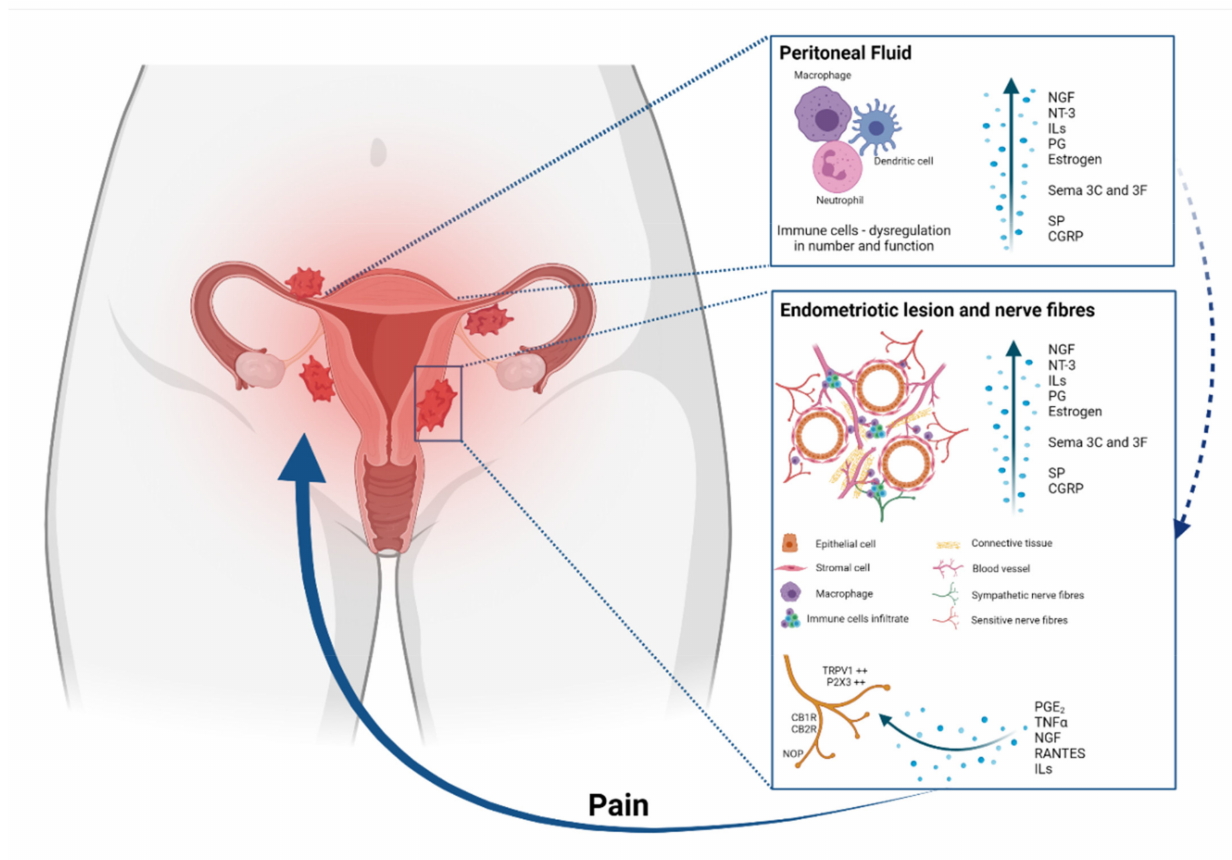
Figure 1. Main pathways involved in the pathogenesis of inflammatory pain in endometriosis. Endometrial fragments in the peritoneum lead to peritoneal inflammation. The same immune response is seen at endometriotic lesions, where the increased production of cytokines, chemokines, growth factors and immune cells also contributes to an enhanced inflammatory environment present in the peritoneal cavity of women with EM. Of these inflammatory mediators, PGE2, tumour necrosis factor- α (TNF α ), nerve growth factor (NGF), RANTES and interleukins are also able to stimulate sensory nerve endings and activate a positive feedback loop, further increasing proinflammatory modulator production. The expression of pain receptors is also increased in EM patients’ nerve fibres. The enhanced stimulation and activation of peripheral nerve endings in the peritoneal cavity increase the painful stimuli, initiating and maintaining chronic pelvic